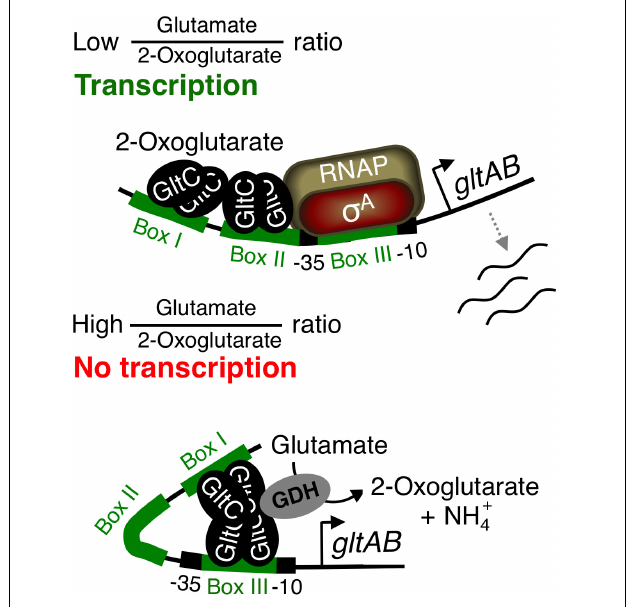
FIGURE 9 | Model for the regulation of the P gltA promoter by GltC and the GDHs. During growth with glucose, GltC binds to boxes I and II of the P gltA promoter and stimulates gltAB transcription by RNA polymerase (RNAP). In the presence of glucose and high amounts of glutamate (e.g., growth with arginine), the glutamate-degrading GDHs RocG and GudB1 convert the activator GltC into a repressor. The binding mode of GltC and the stoichiometry of the protein complex remains to be defined. σ A , housekeeping sigma factor